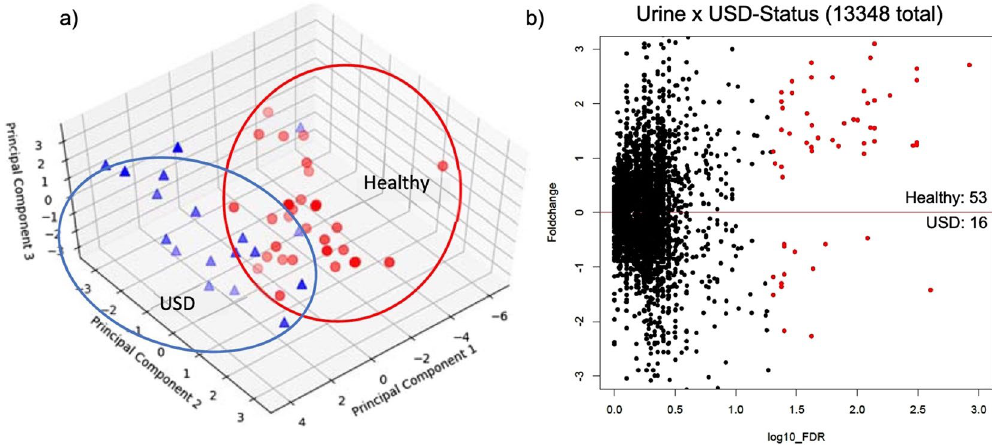
significantly different metabolites are indicated for each group.